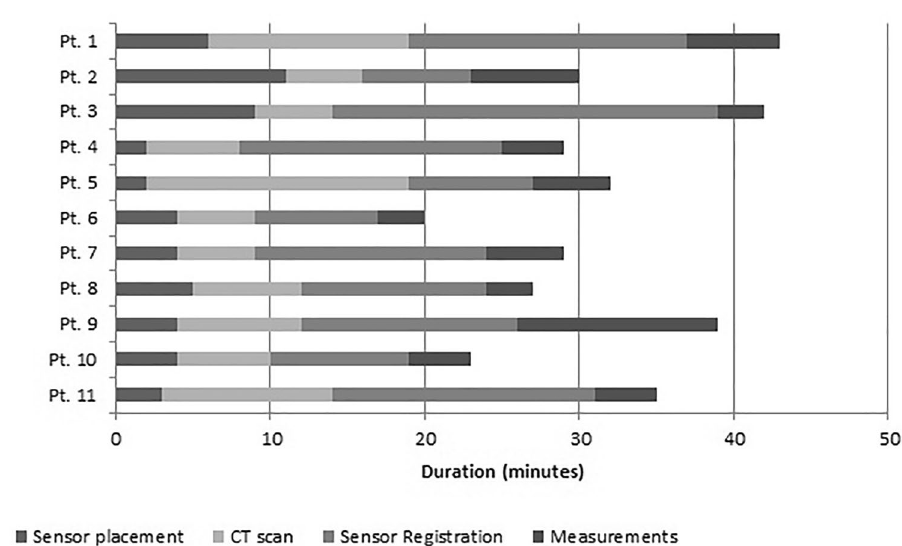
Figure 5. Surgical delay due to navigation